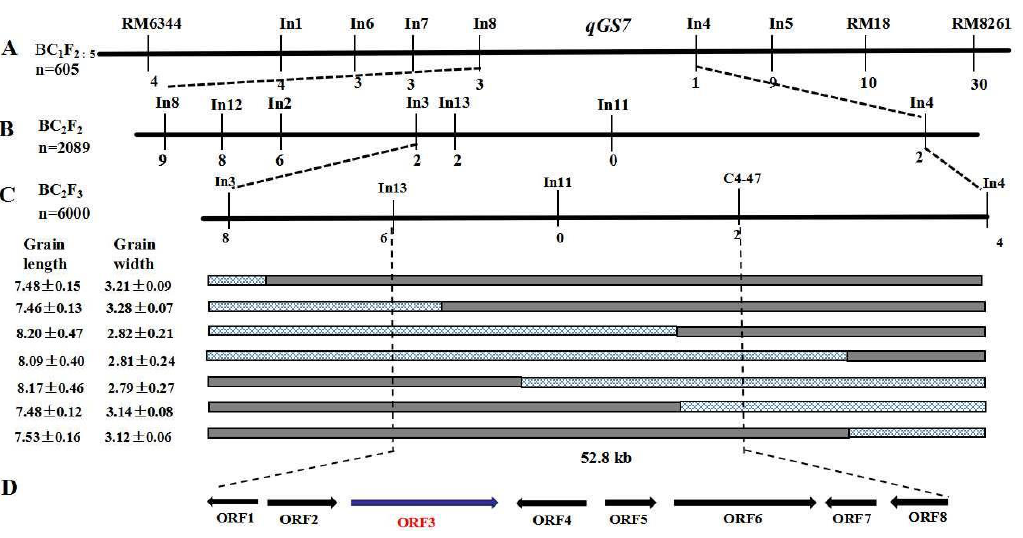
Figure 3. Map-based cloning of qGS7 . ( A ) Physical map of the qGS7 locus using 605 BC 1 F 2:5 plants. ( B ) Physical map of the qGS7 locus using 2089 BC 2 F 2 plants. ( C ) High-resolution linkage analysis of the qGS7 locus using 6000 BC 2 F 3 plants. Grey solid bars represent homozygous chromosomal segments for N643 and grille for heterozygote. ( D ) Predicted open reading frames in the target region of the rice